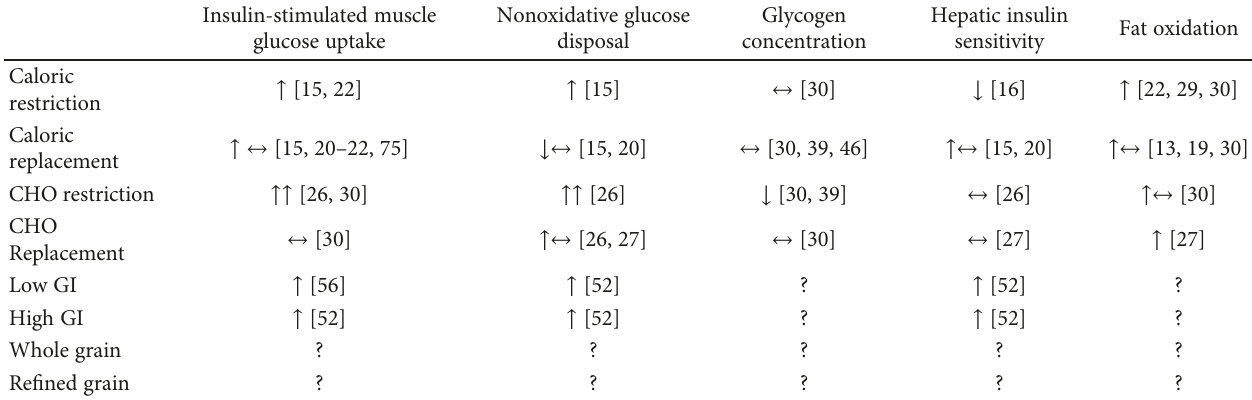
Table 1: Summary of exercise plus diet e ff ects compared with